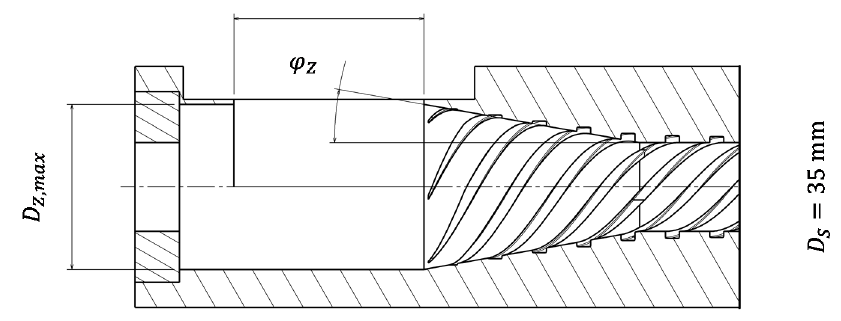
Figure 10. Variation of geometry parameters of the feed zone.